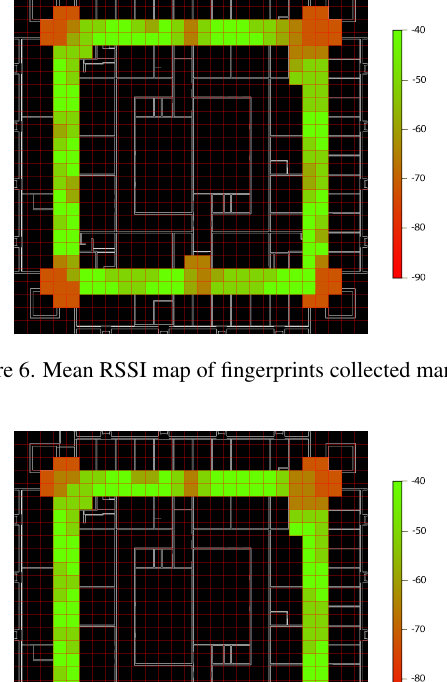
Figure 9. Maps for reference point identified using k NN +